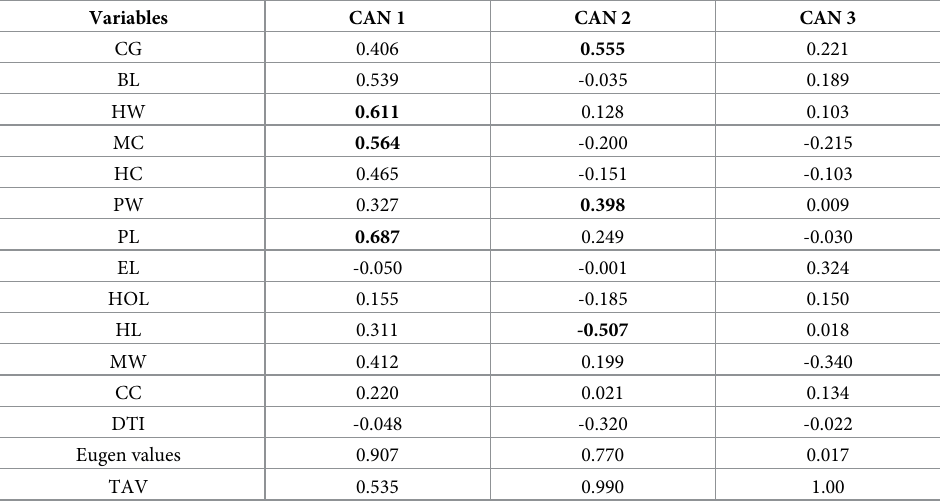
Table 4. Total canonical structure.